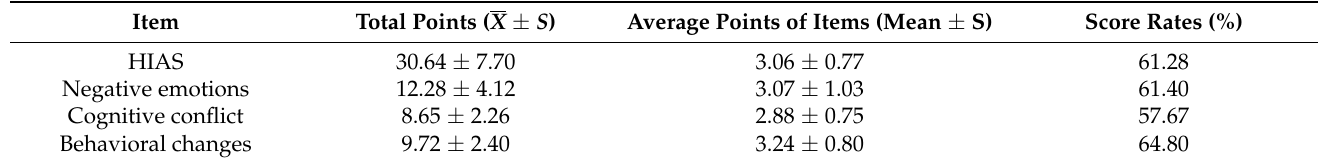
Table 1. COVID-19 information avoidance among elderly people in Wuhan, China ( n = 907).